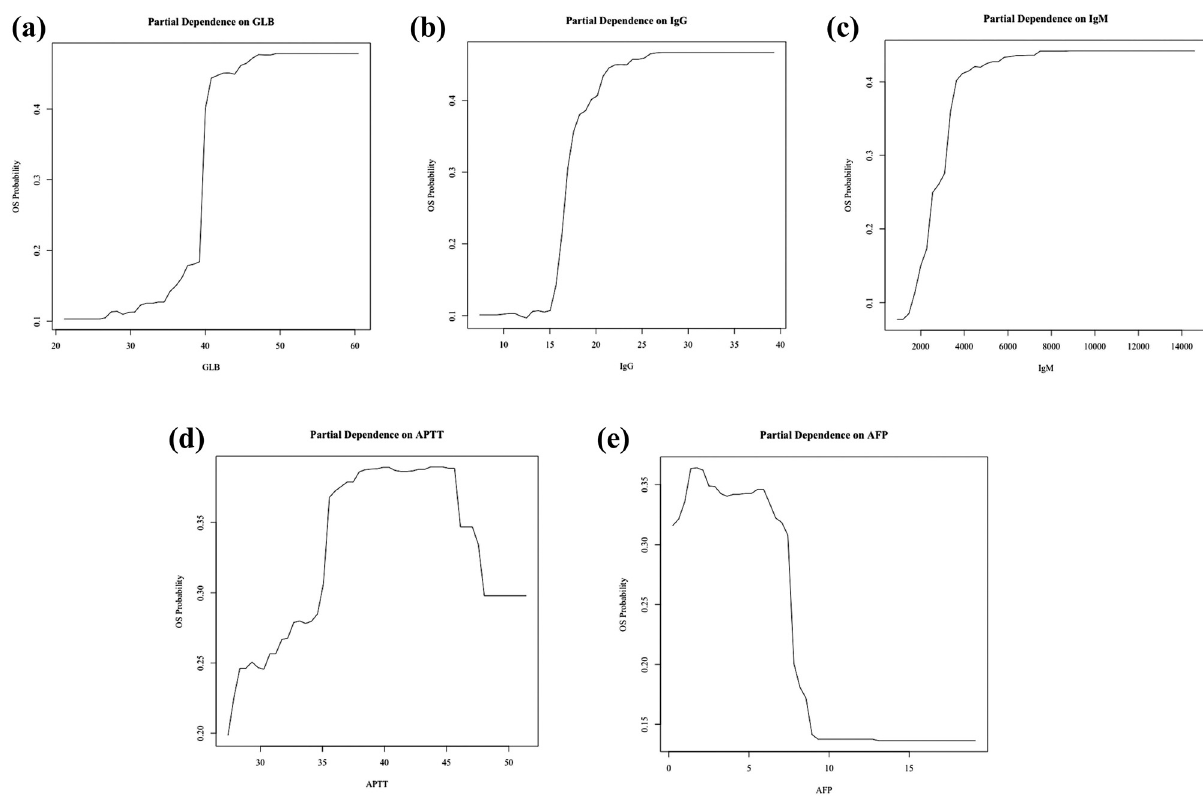
Figure 3: The e ff ects of fi ve important variables on the outcome of diagnosing OS. ( a ) GLB. ( b ) IgG. ( c ) IgM. ( d ) APTT. ( e ) AFP.